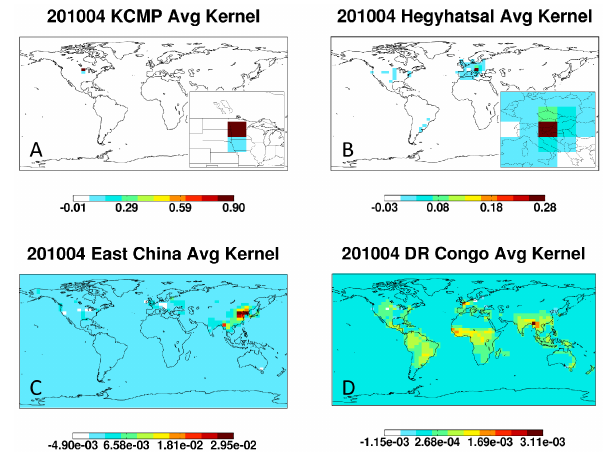
Figure 10. Rows of the averaging kernel for the inversion of N 2 O emissions based on surface observations. The results indicate how well emissions in a particular location can be resolved from emis- sions elsewhere, and are shown for four example sites: (a) KCMP tall tower, (b) Hegyhátsál, Hungary, (c) a grid cell in East China, and (d) a grid cell in the Democratic Republic of Congo. Insets show re- gional detail for the first two sites. KCMP is a site with continuous observations, Hegyhátsál is a site with ∼ weekly flask observations, the East China site is a location with flask observations ∼ 1000km downwind, and the Congo site is a remote